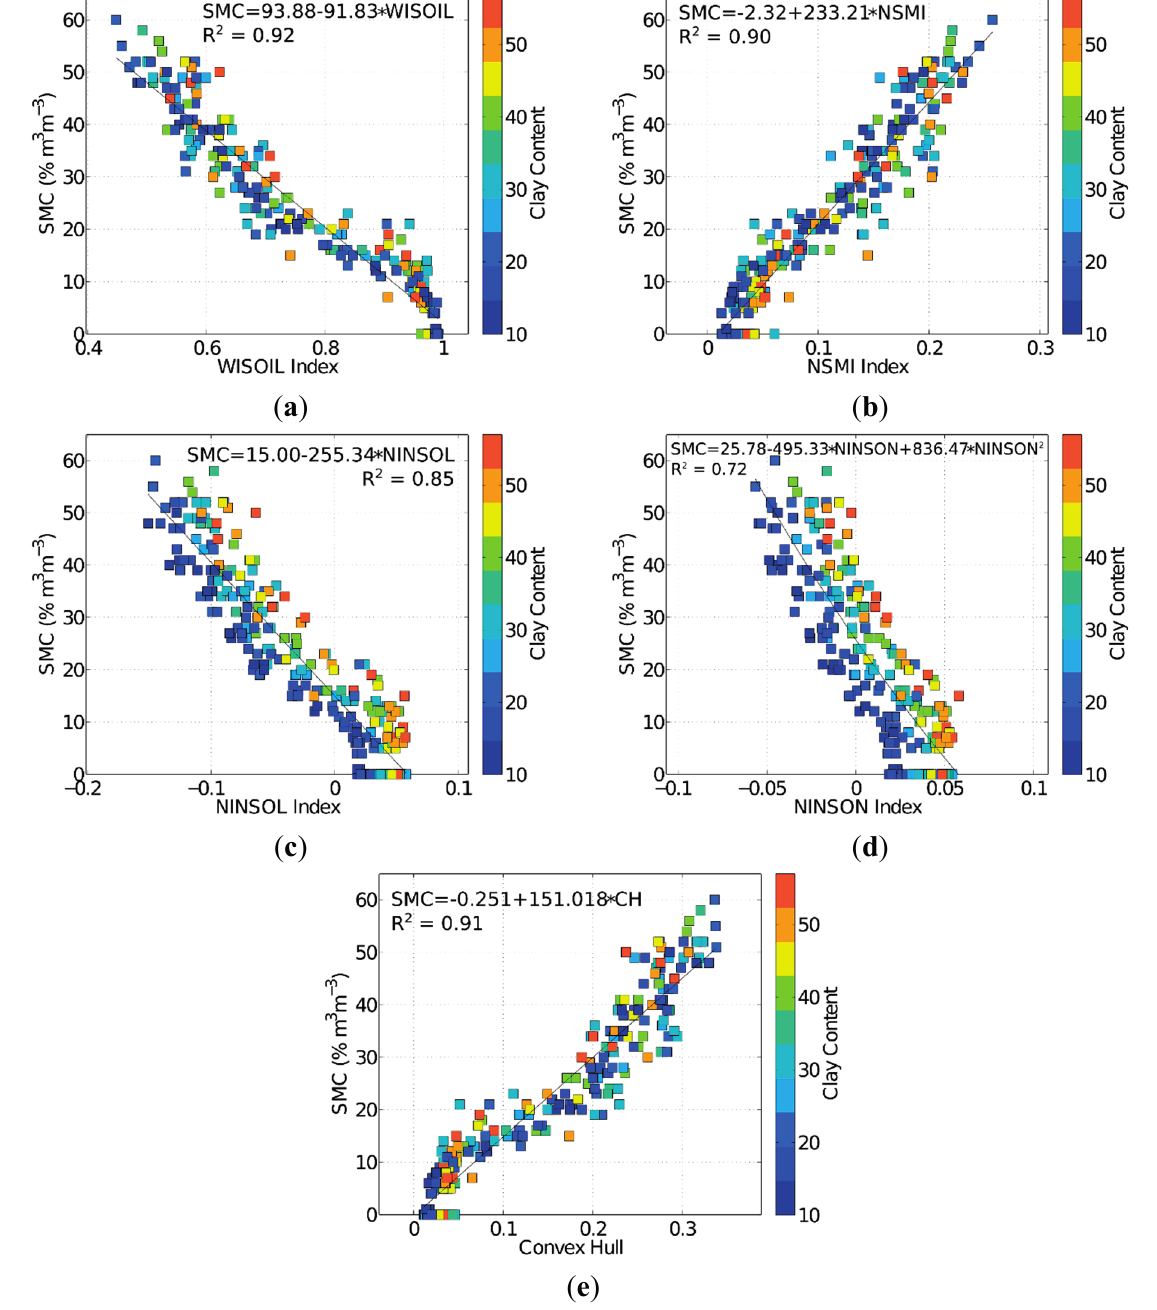
Figure 8. Comparison of the relationships estimated between measured soil moisture content and ( a ) WISOIL index; ( b ) NSMI index; ( c ) NINSOL index; ( d ) NINSON index and ( e ) the area between the spectra and the CH criteria. The colour bar indicates the clay content